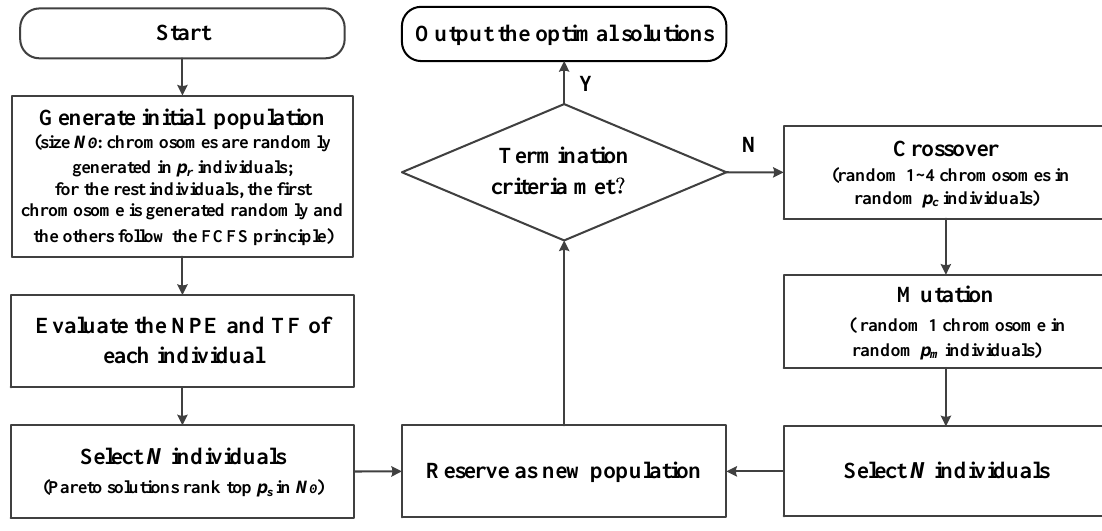
Figure 3. The flowchart of the MCEA.